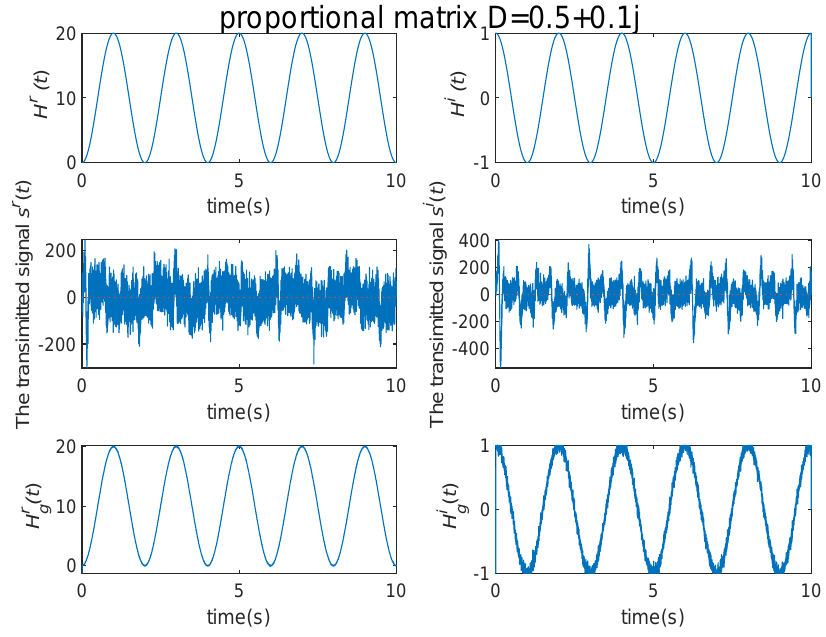
Figure 7. The CMPDFS process with noise when D = 0.5 + 0.1 j .